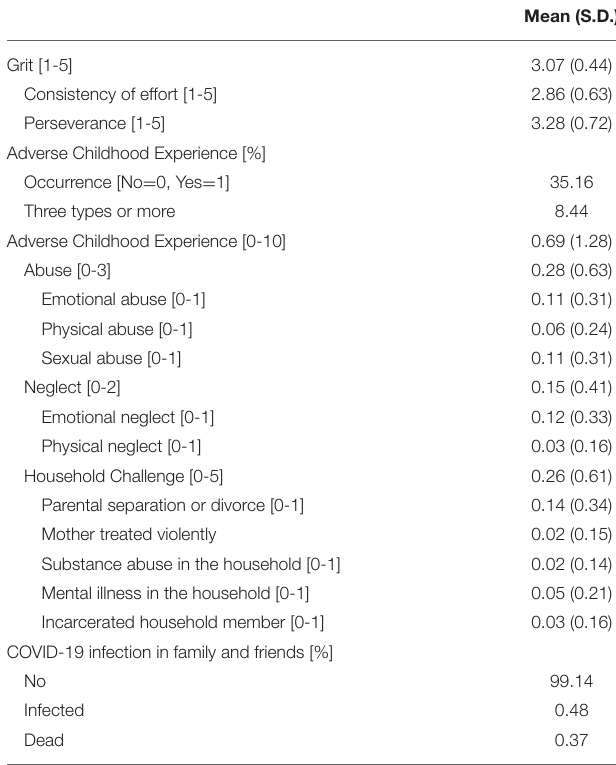
TABLE 2 | Level of grit, adverse childhood experience, and COVID-19 infection.